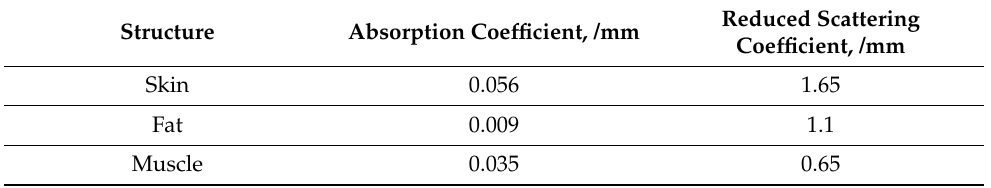
Table 1. Optical properties of cheek tissues for 850 nm light.